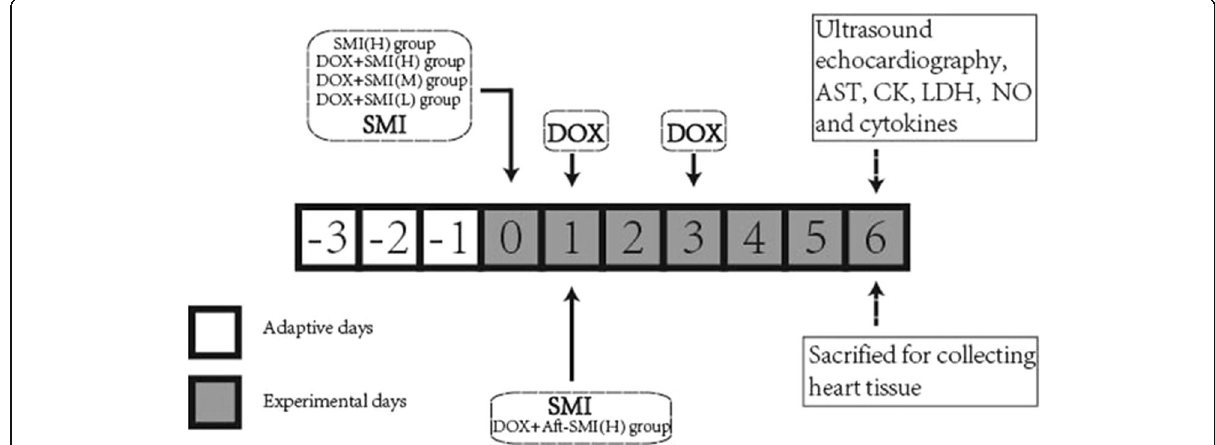
Fig. 2 The experimental protocol